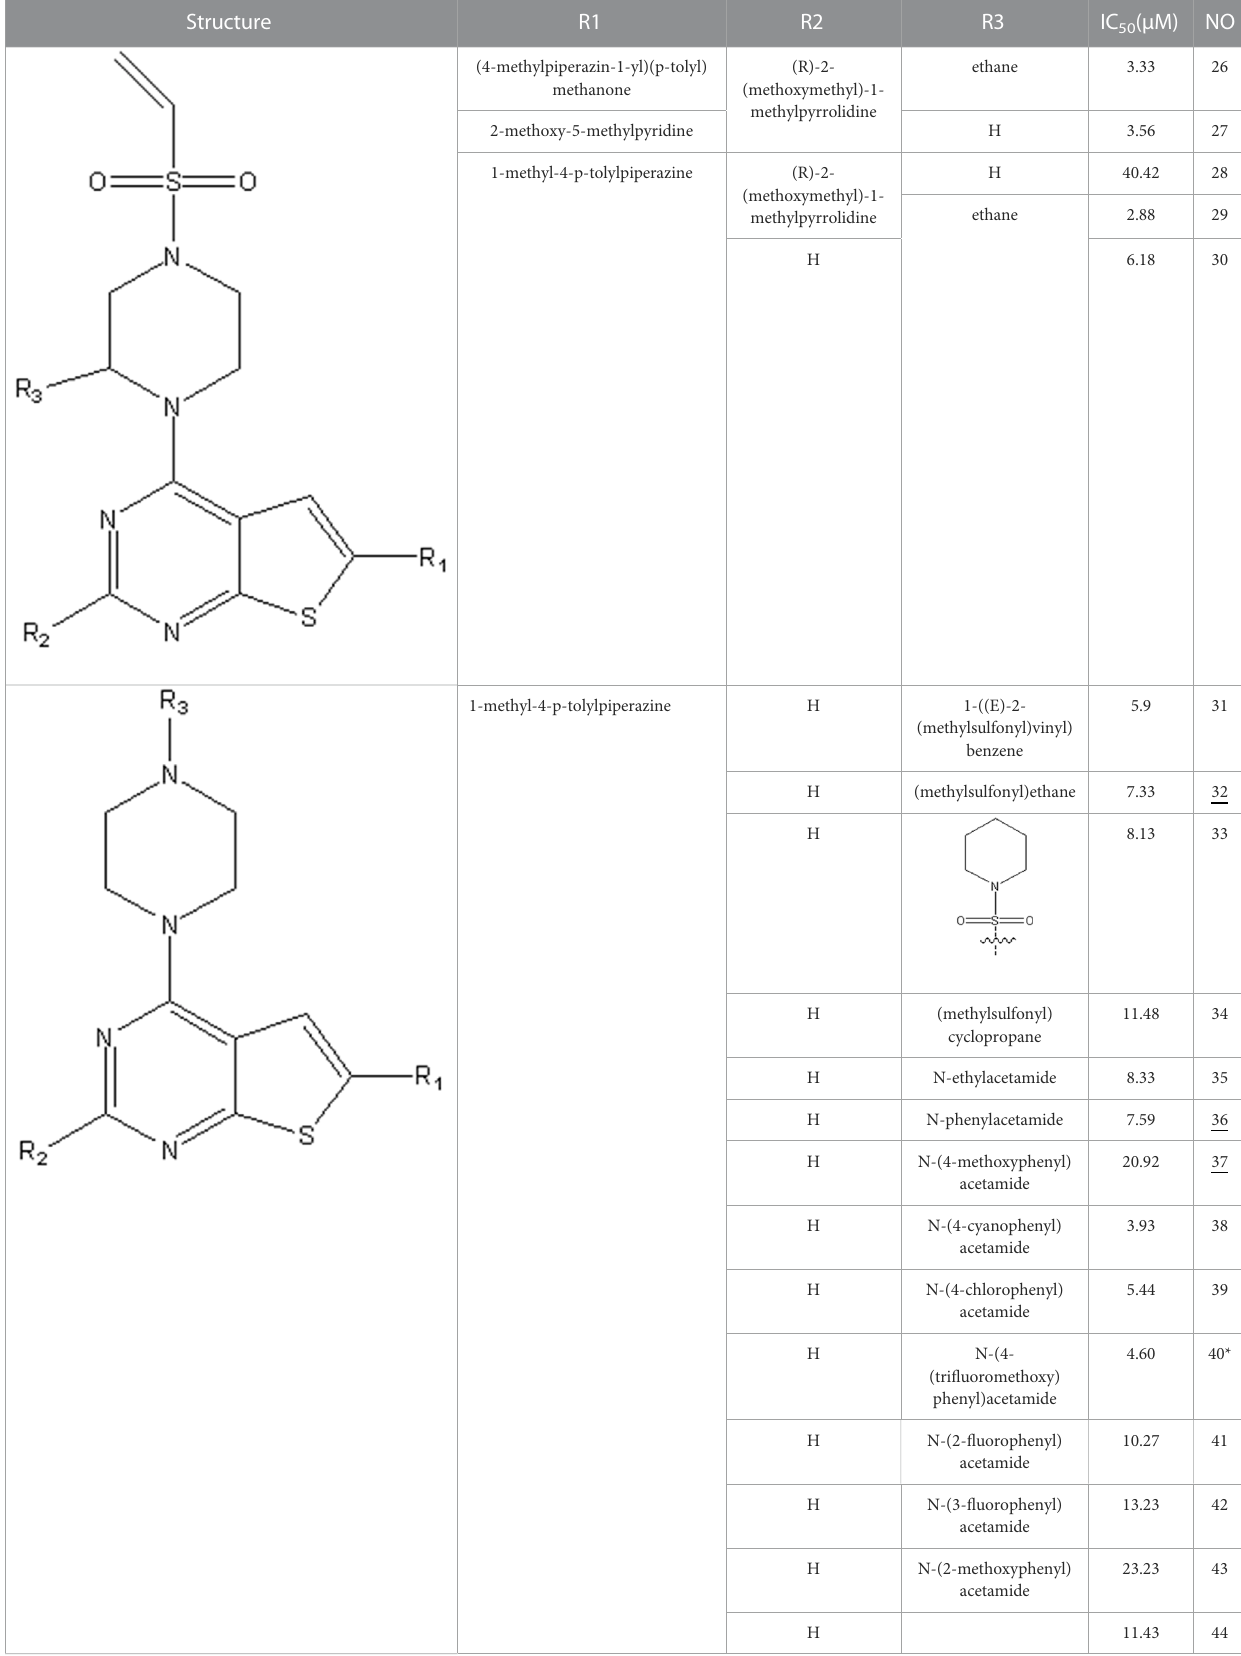
TABLE 1 ( Continued ) VEGFR3 kinase inhibition and activity values of compounds 1- 50.